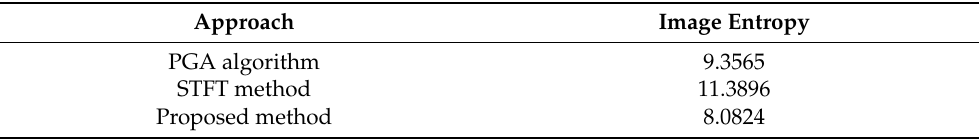
Figure 10. ISAR imaging results with different approaches. ( a ) PGA imaging results. ( b ) STFT imaging results. ( c ) Our proposed method. Table 2. Image entropy of corresponding imaging method.